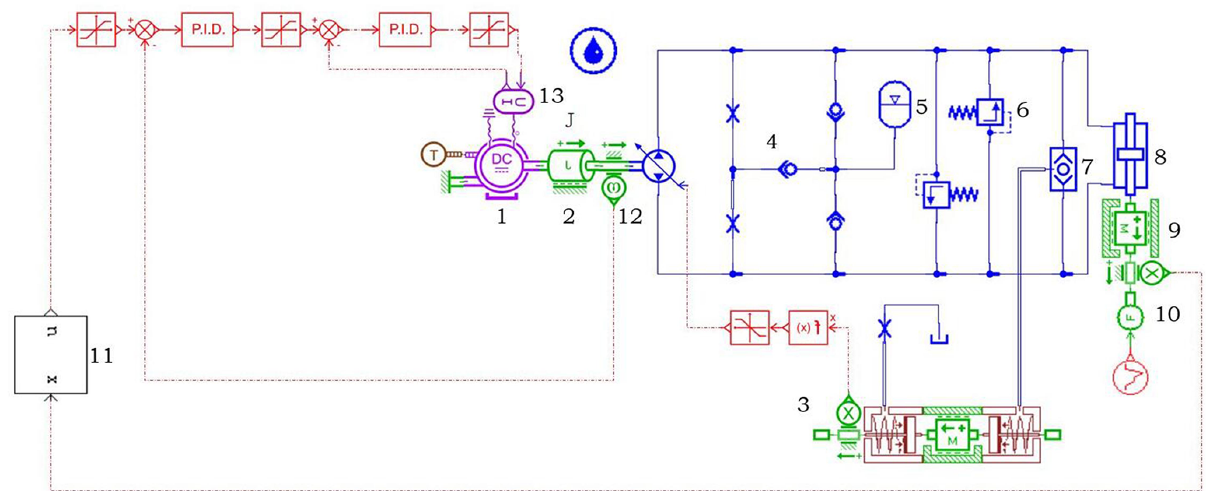
Figure 6. Simulation model of hydraulic system of the HPLS-EHA: (1) brushless DC motor; (2) moment of inertia module; (3) displacement regulator; (4) check valve; (5) energy accumulator; (6) pressure relief valve; (7) shuttle valve; (8) actuator cylinder; (9) load; (10) force